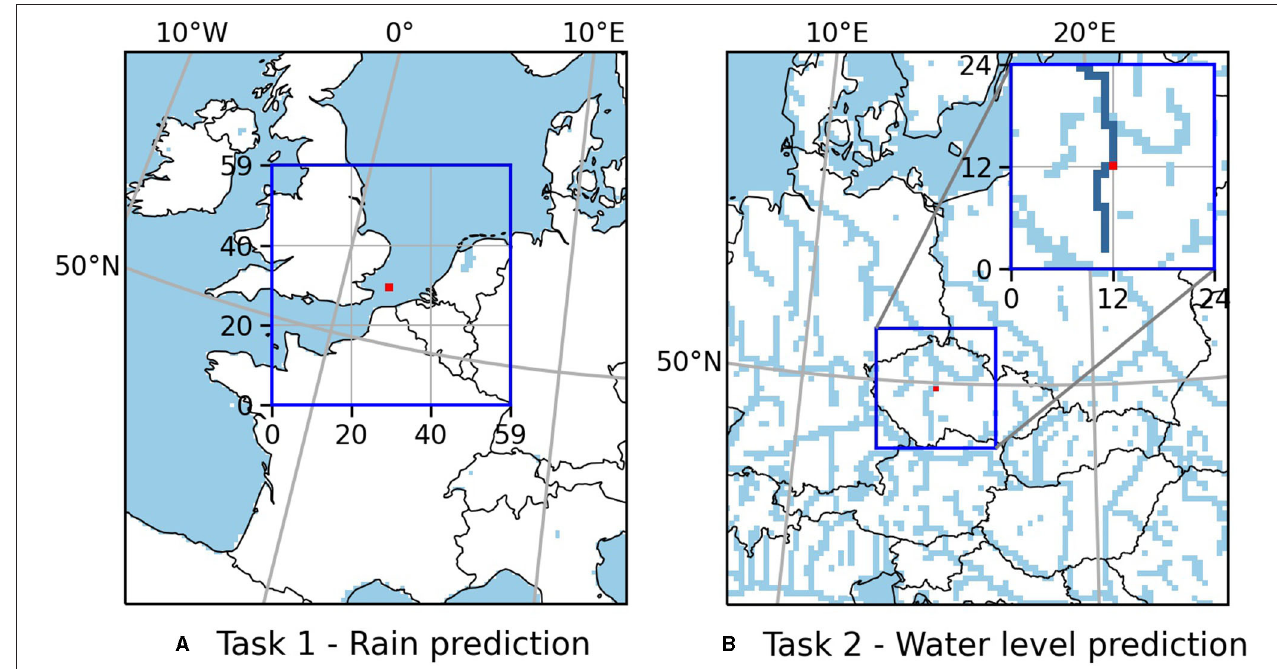
FIGURE 1 | Set up of the two original prediction tasks. (A) Predict whether the precipitation averaged over the red 2 × 2 pixels target patch in the center of the 60 × 60 pixels input region exceeds 1 mm in the next 3 h. (B) Predict the water level at the red pixel given the water level 48 h earlier at the red pixel and the pixels upstream and downstream marked dark blue in the inset. Light blue indicates pixels with ponded water at the land surface during the entire simulation period (rivers, lakes,